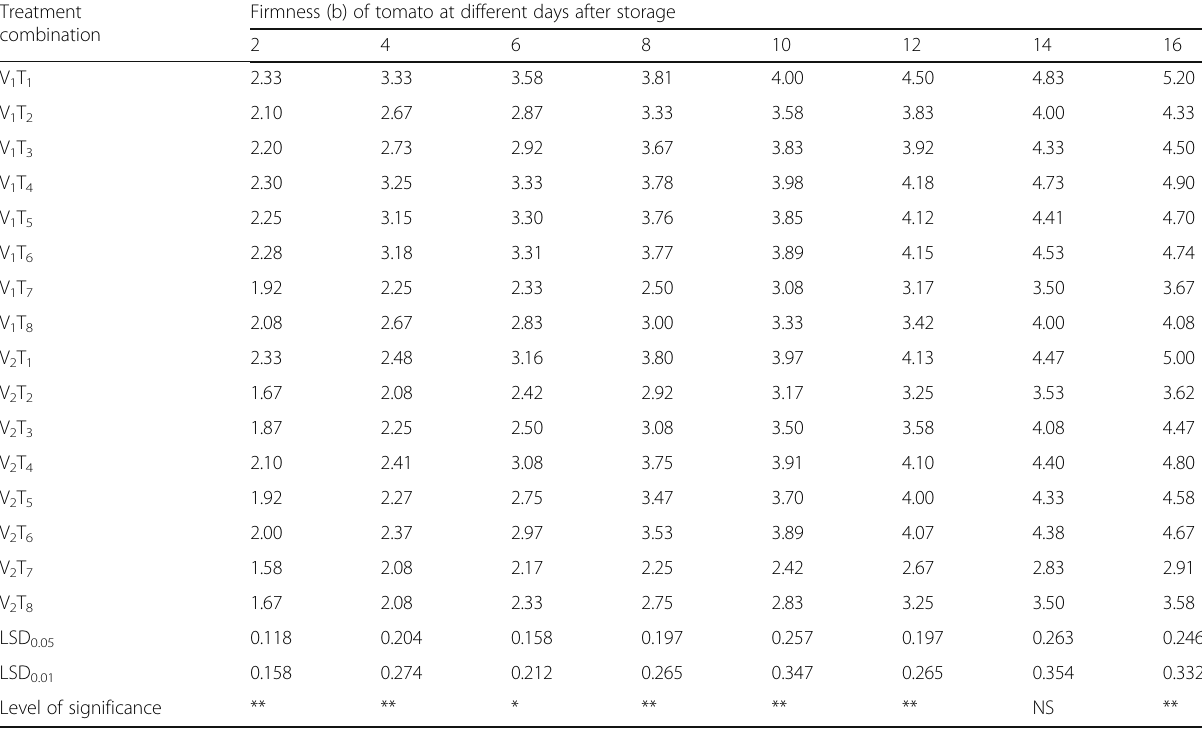
Table 4 Combined effect of varieties and postharvest treatments on firmness of tomato during storage and ripening Treatment combination